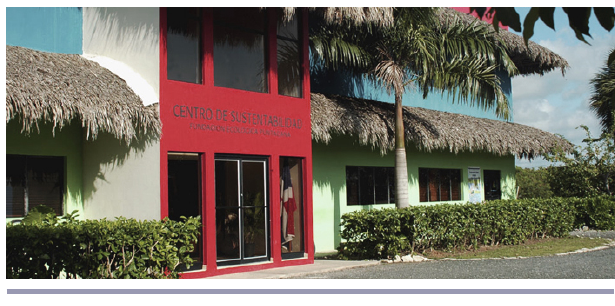
Fig. 4 . Main Center for Sustainability facility in Punta Cana. (© Puntacana Ecological Foundation)